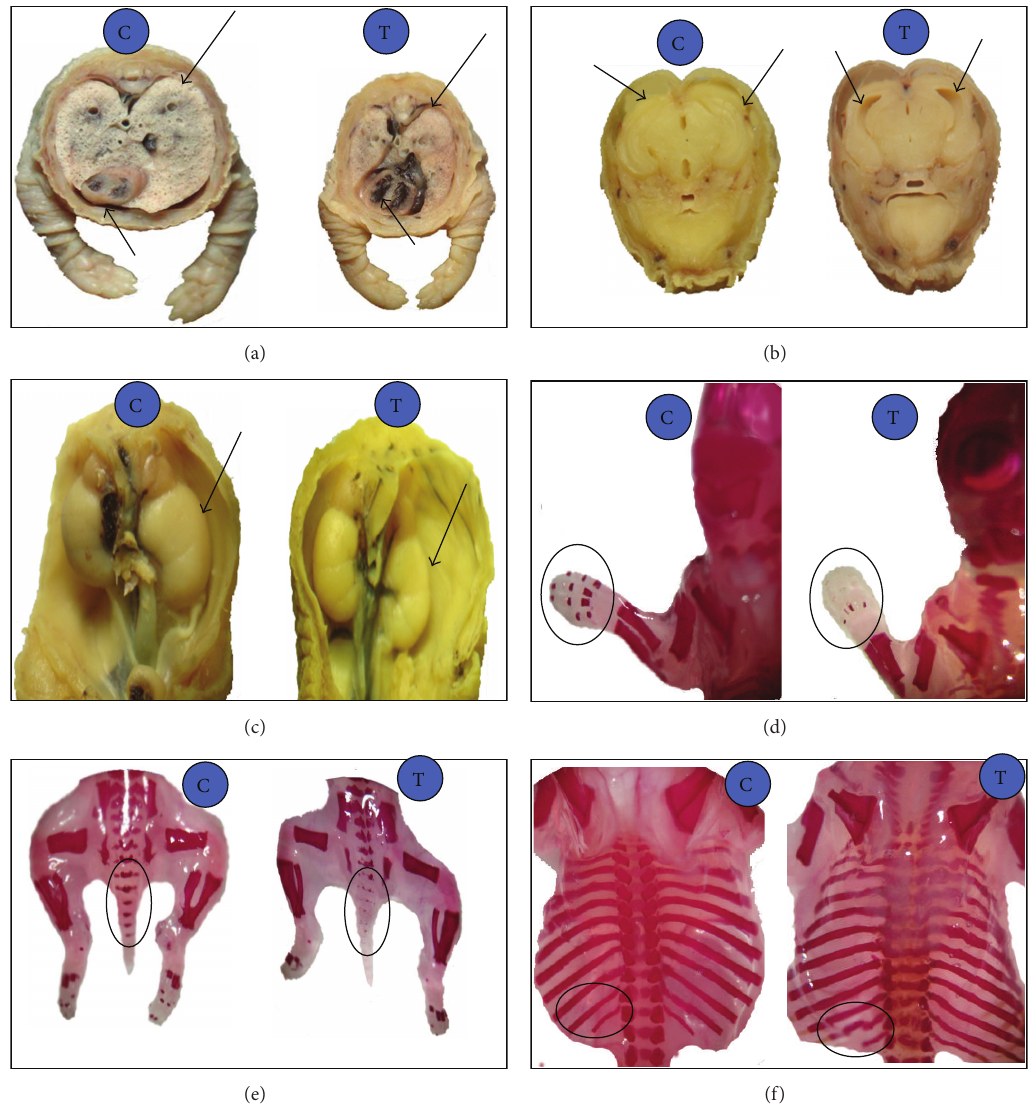
Figure 1: (a) Pulmonary hypoplasia with cardiac enlargement, (b) diverticulum dilatation, (c) kidney hypoplasia, (d) absence of digit’s bone of fore limb, (e) partial absence of caudal vertebrae, and (f) irregular and short ribs of a fetuses obtained from pregnant rats after repeated oral administration of 2000 mg norfloxacin/Kg ⋅ b ⋅ wt from 6th to 15th day of pregnancy. C in blue circle represent (control group) and T in blue circle represent (treated